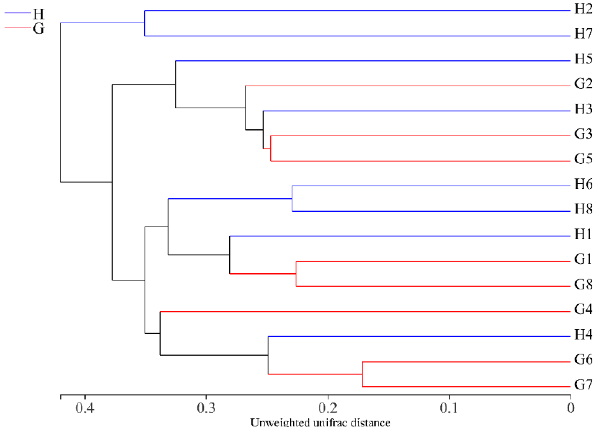
Figure 3. Unweighted unifrac clustering map of fungi in the Suanyu samples based on OTU pattern. Same clades: similar fungal composition. G1 – G8: Suanyu samples from Guizhou; H1 – H8: Suanyu samples from Hunan.